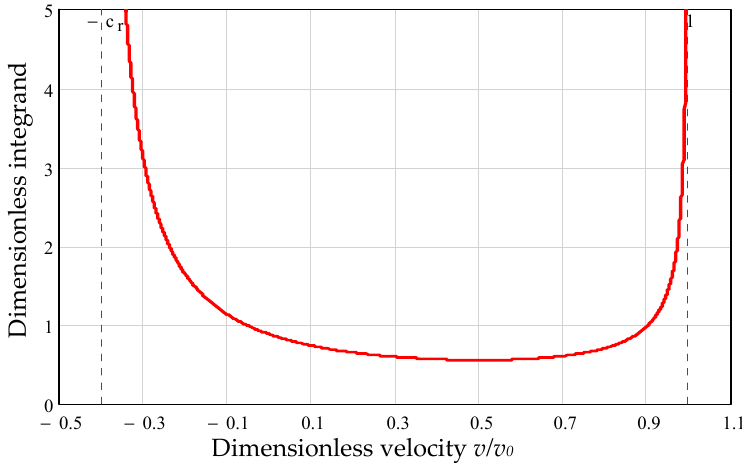
Figure 8. Asymptotes of integrand from Equation (56).